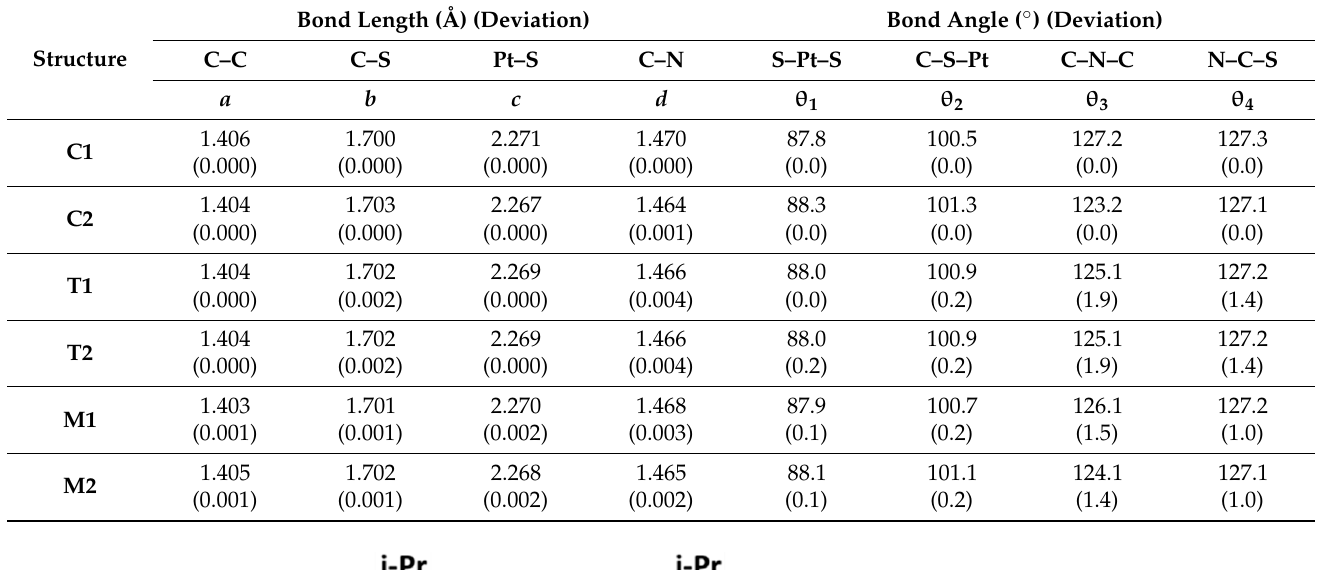
Table 1. Table of average bond lengths (in Å), bond angles (in degree), and their deviation from average (placed in parentheses) in the optimized structures of [Pt(iPr 2 timdt) 2 ] complexes. The Figure 3 illustrates the positions of the bonds and angles being investigated.